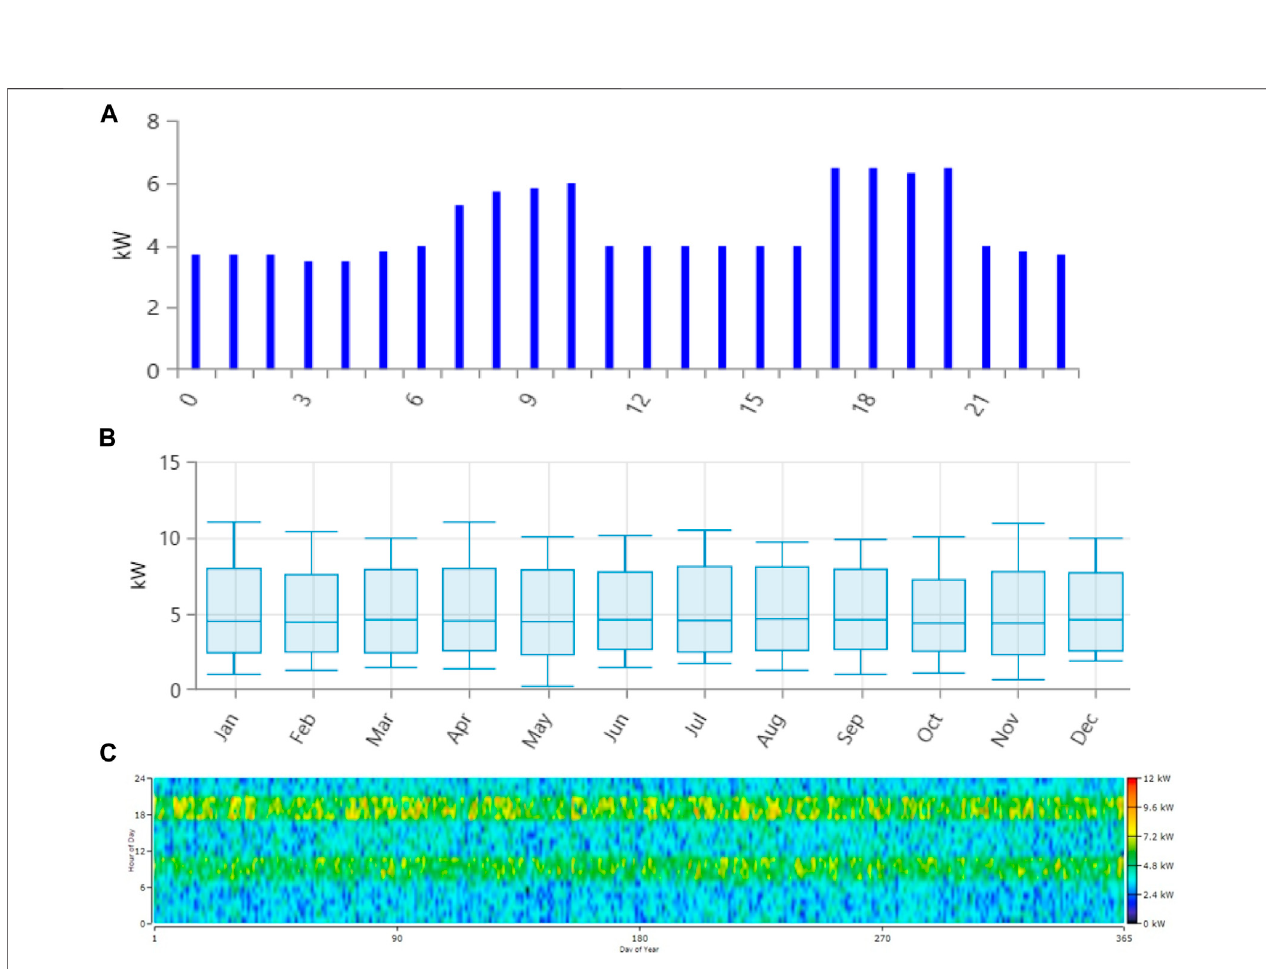
FIGURE 4 | (A) Daily load pro fi le for a residential load (Hours/day). (B) Monthly load pro fi le for a residential load. (C) DMAP of the yearly load pro fi le for a residential